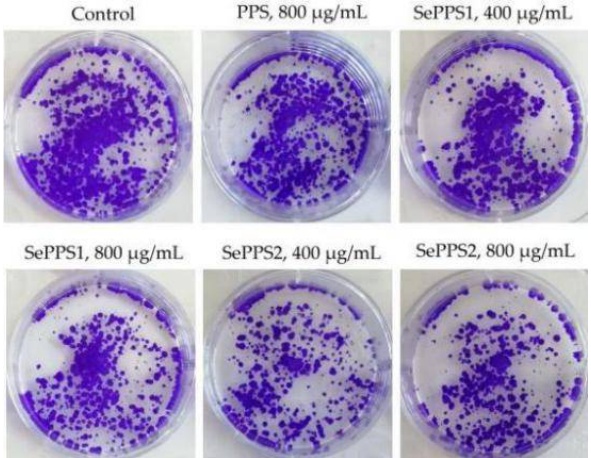
Figure 4. The observed inhibitory effects of P. oleracea polysaccharides (PPS) and two selenylated PPS products (SePPS1 and SePPS2) at two dose levels on HCT-116 cells with a treatment time of 14 d using the colony formation experiment.